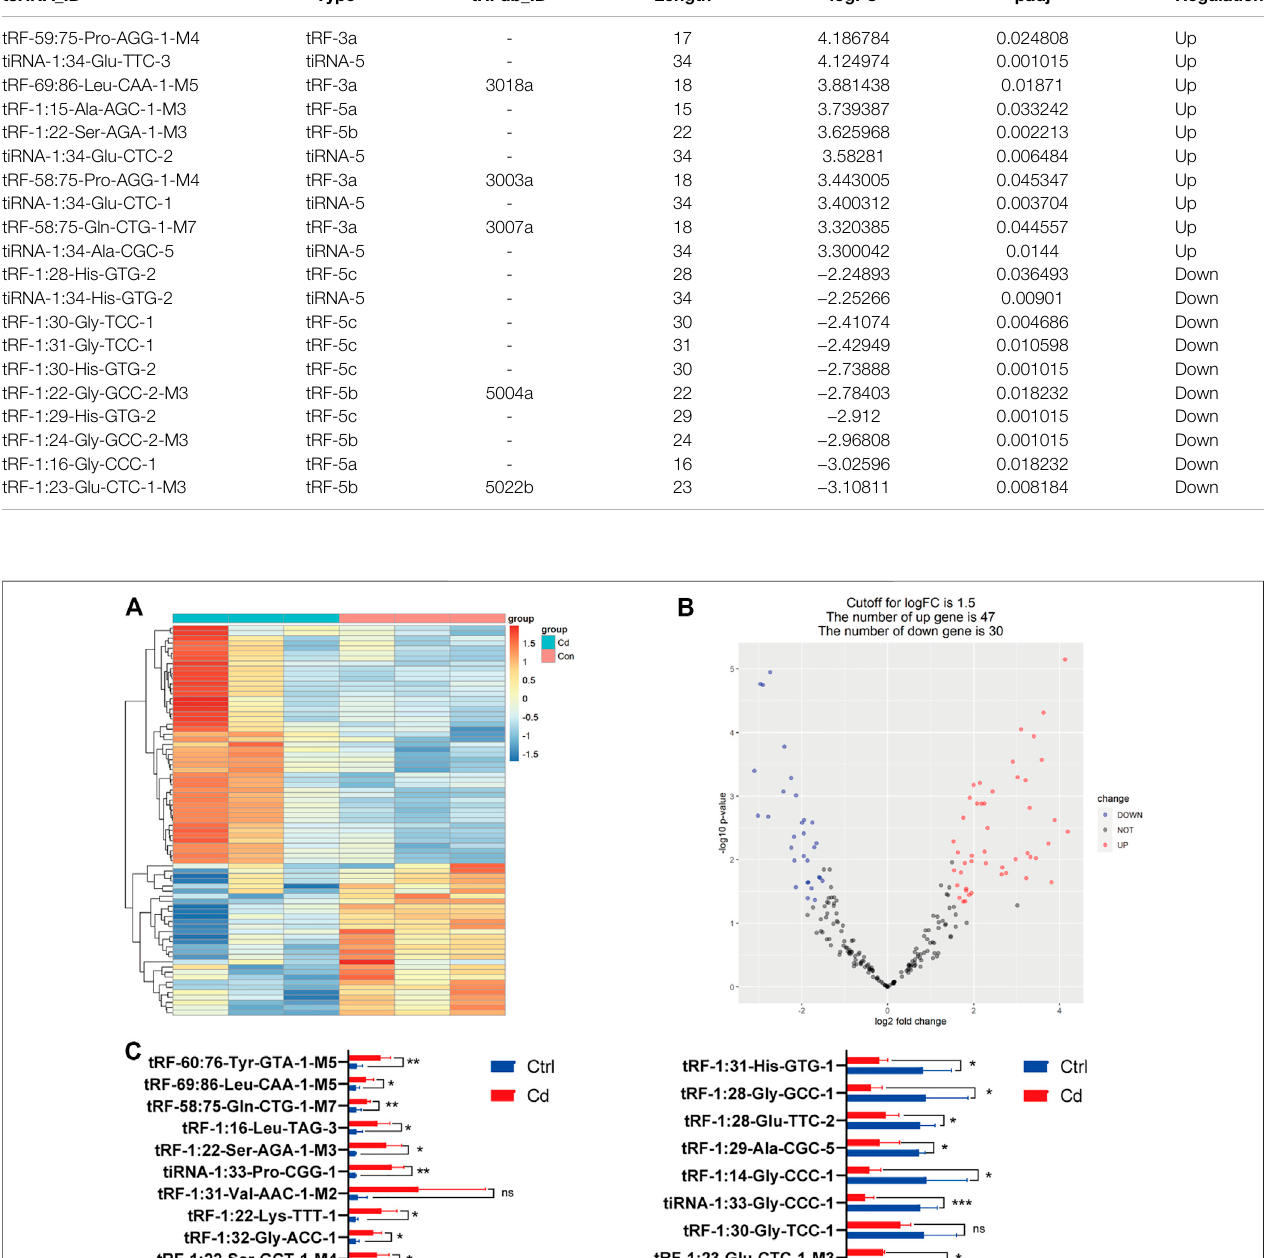
Frontiers in Cell and Developmental Biology |